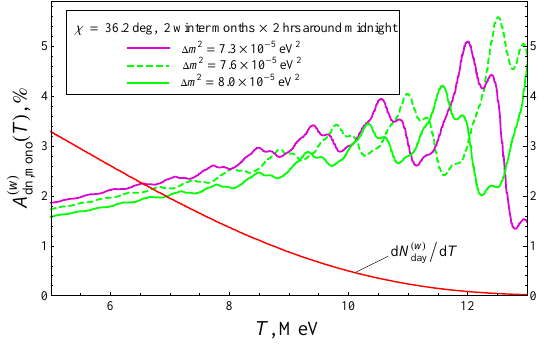
Figure 3. Signatures on the weighted ‘experimental’ asymmetry (6) for di ff erent neutrino mass-squared di ff erences ∆ m